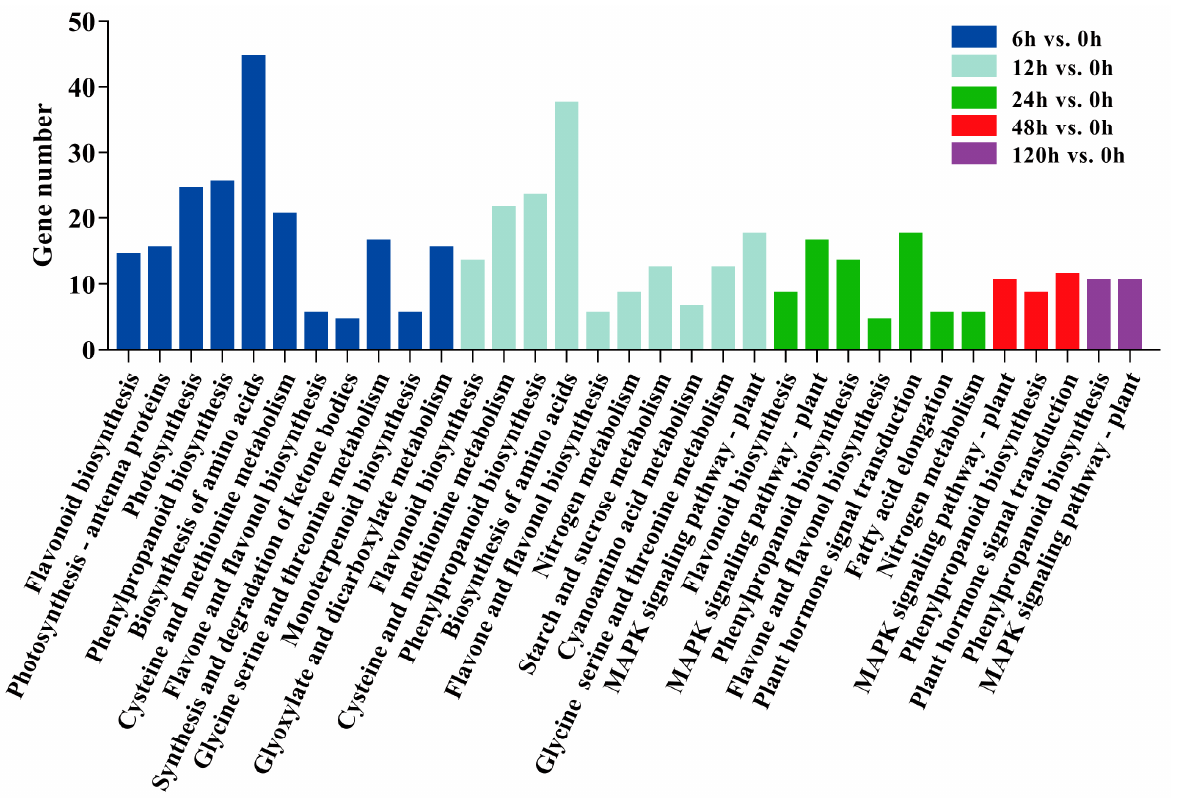
Figure 4. KEGG enrichment analysis of DEGs.